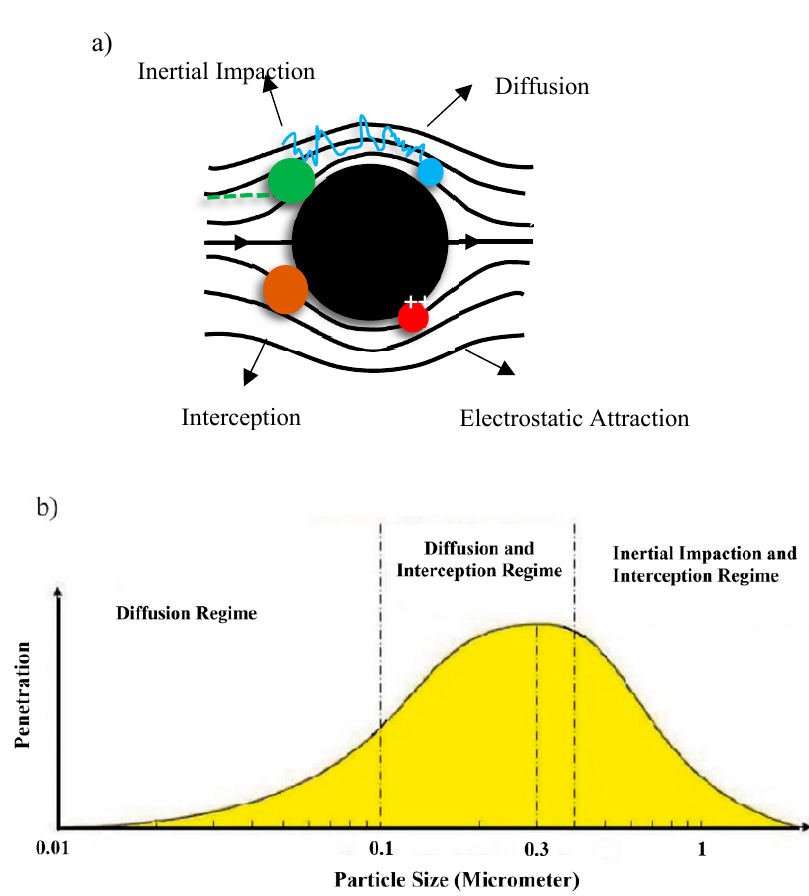
Figure 12. ( a ) Different collision of particles based on the four main filtering mechanisms. ( b ) The relationship between particle size distribution and type of filtering mechanisms [55,56]. Table 6. Test parameters and details of related roles in filtration efficiency [57,58].